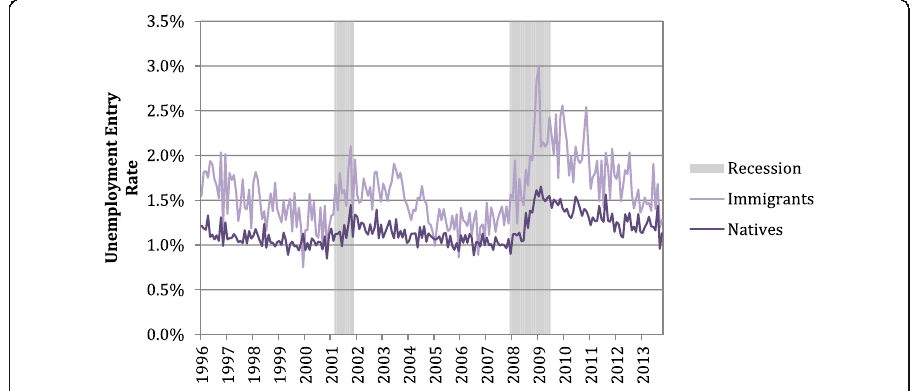
Fig. 2 Seasonally adjusted monthly unemployment entry rates: matched CPS data, 1996 – 2013. Notes: Monthly unemployment entry rates are calculated by author using the matched CPS data. All data are seasonally adjusted. The sample consists of people aged 20 – 64 who are in the labor force for any two consecutive months. Shaded area represents recessions as reported by the National Bureau of Economic Research